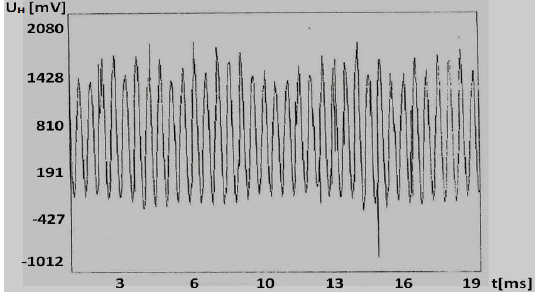
Figure 12. Hall voltage versus time for efficient starter, Hall sensors fixed on the stator, unloaded starter.